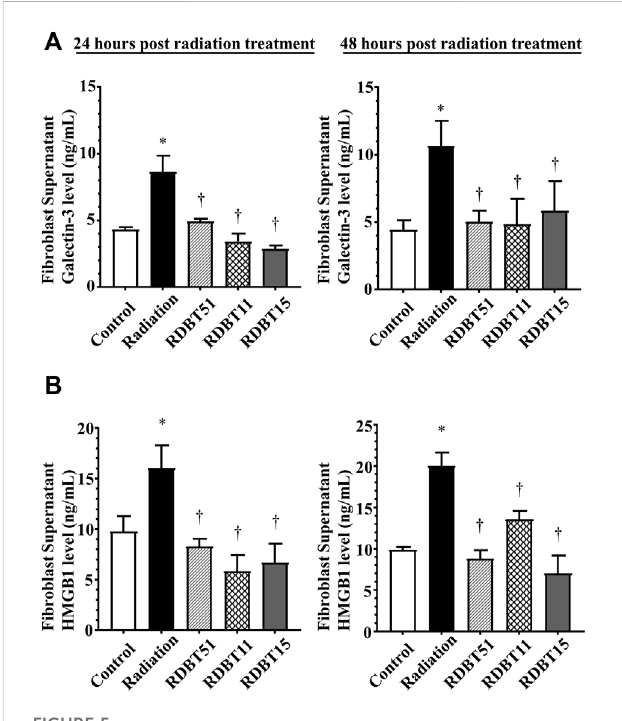
FIGURE 5 The DBT reduces the fi brosis-related biomarkers in the neonatal mouse myocardial fi broblast culture supernatant at 24 and 48 h after radiation. (A) Galectin-3; (B) HMGB1. * p < 0.05 versus Control; † p < 0.05 versus Radiation. DBT, Dang Gui Bu Xue Tang; HMGB1, high mobility group box 1; RAM, Radix Astragali membranaceus ; RAS, Radix Angelicae sinensis ; RDBT51, Radiation with DBT (RAM: RAS = 5:1); RDBT11, Radiation with DBT (RAM: RAS = 1:1); RDBT15, Radiation with DBT (RAM: RAS =